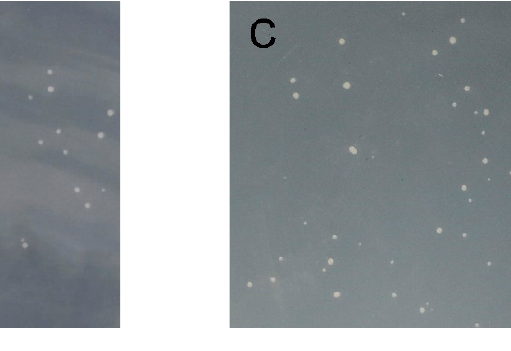
Figure 5. ( A ) DDO plate. ( B ) TDO plate. ( C ) QDO plate.